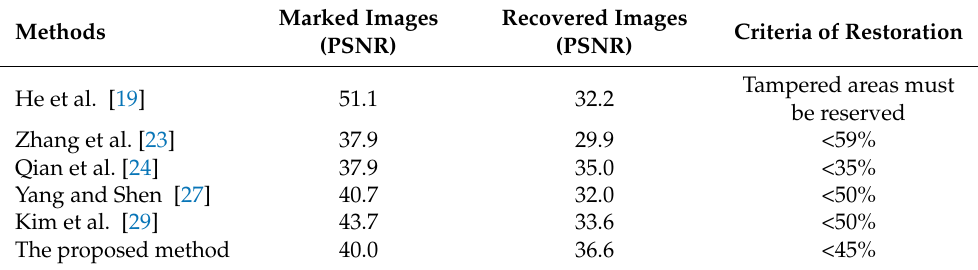
Table 3. Comparisons of PSNR of marked image and recovered image among different schemes. Methods